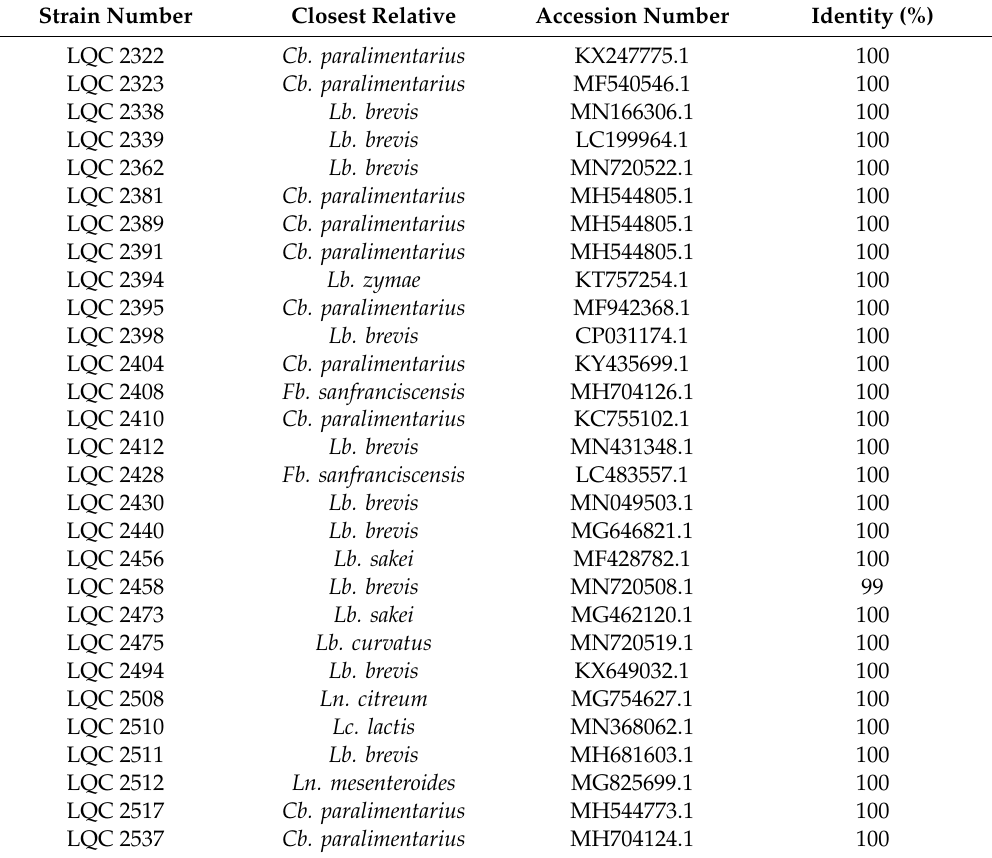
Table 3. Taxonomic a ffi liation of bacterial strains based on sequencing of the V1–V3 region of the 16S rRNA